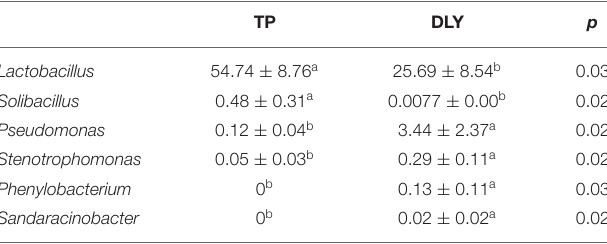
TABLE 7 | The differential jejunal microbiota at the genus level for TP and DLY